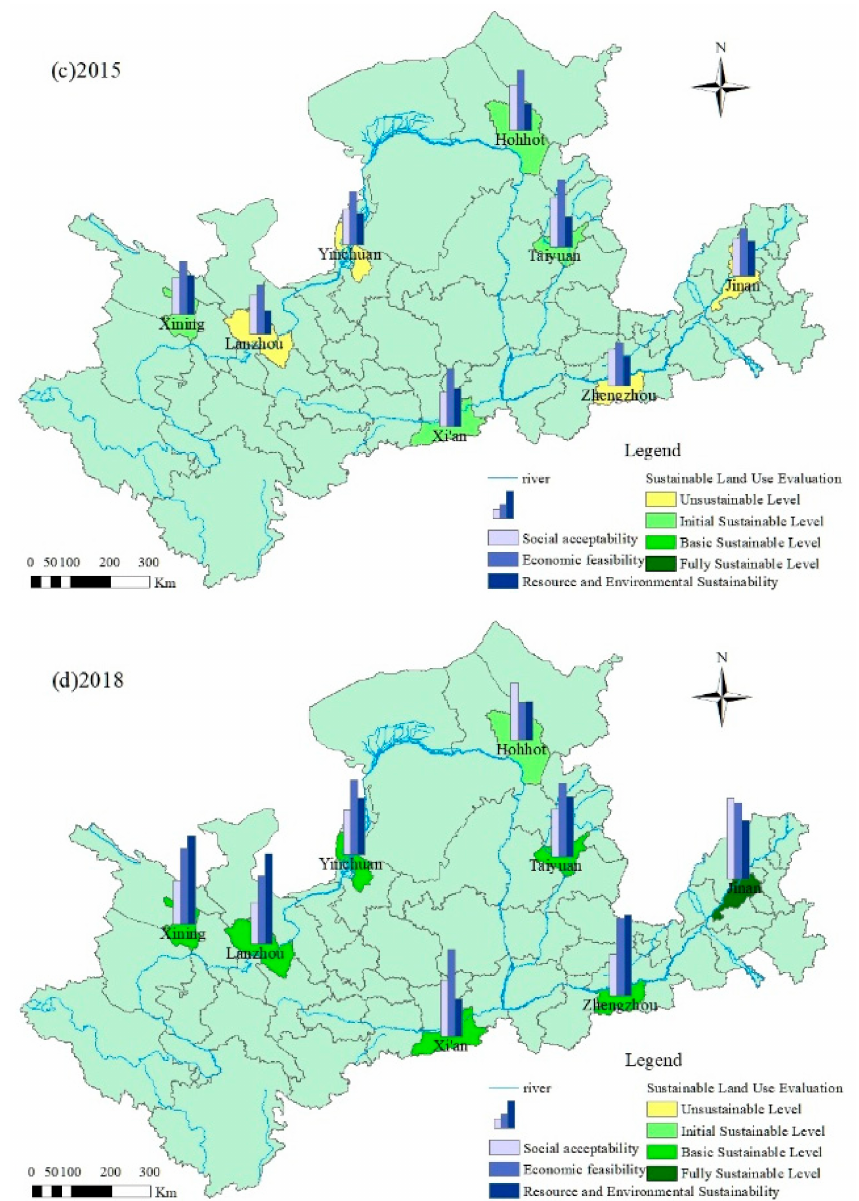
Figure 2. Analysis of spatial disparities in SLU in central cities of the Yellow River Basin,